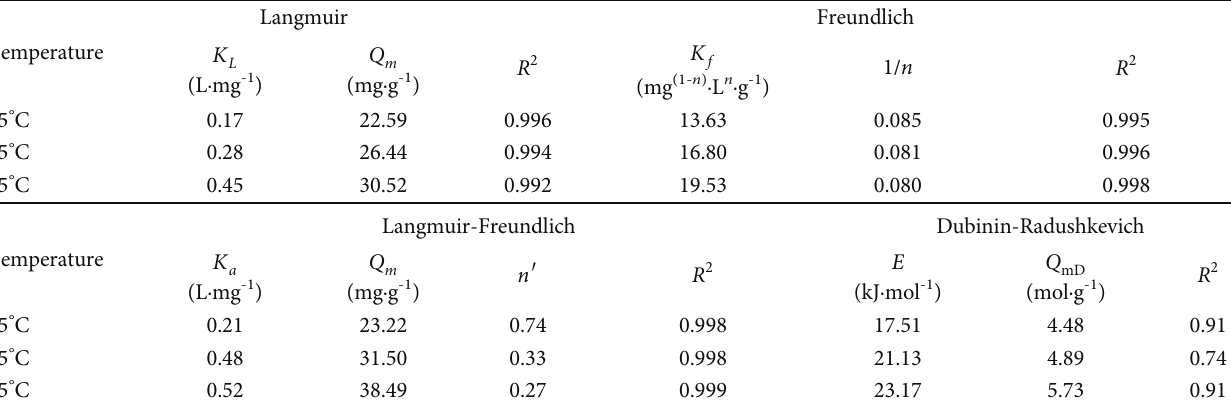
Table 4: Fitting parameters of four isotherm models.